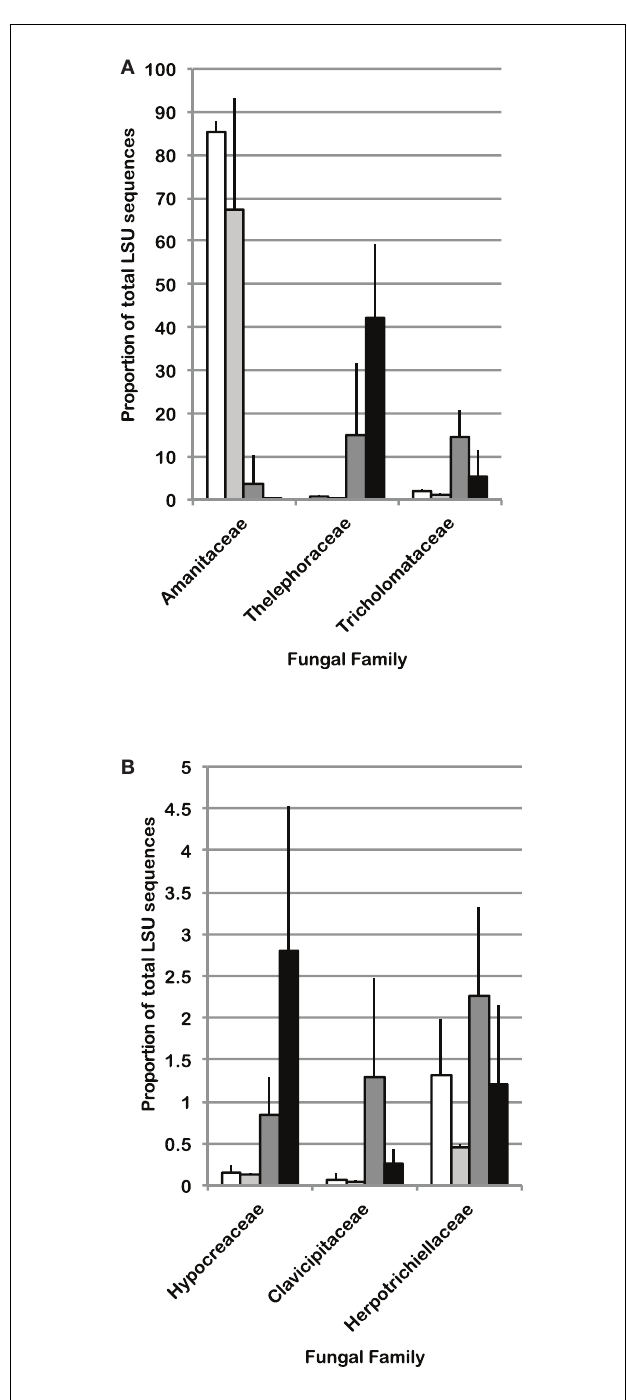
FIGURE 4 |Average percent of sequences in LSU 454 pyrotag libraries classified as (A) Basidiomycota or (B)Ascomycota, for which statistically significant differences (ANOVA p < 0.10 using a factorial model) were identified among field treatments in the 0–2cm depth interval ( n = 3). White bars: aCO 2 , light gray bars: eCO 2 , dark gray bars: N-fertilization, black bars: eCO 2 +